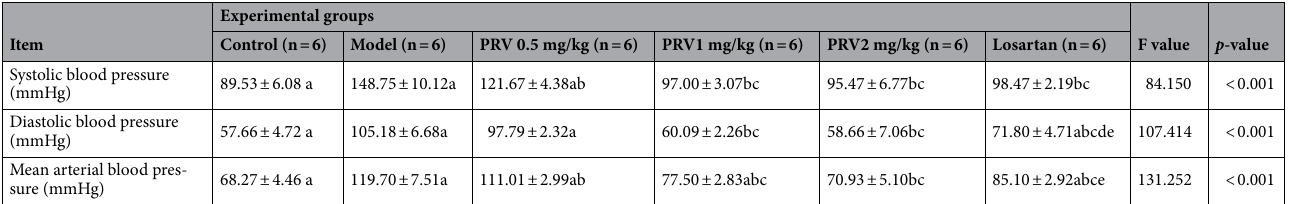
Table 1. Mean ± SD for the arterial blood pressure measurements among different experimental groups. The results are presented as the means ± standard deviation (SD). The groups with different superscripts in the same row represent a statistical significance ( p < 0.05), a: control; b: model (dexamethasone-treated group); c: PRV 0.5 mg/kg; d: PRV1mg/kg; e: PRV 2 mg/kg. n number/group, PRV propolis, royal jelly & bee venom.